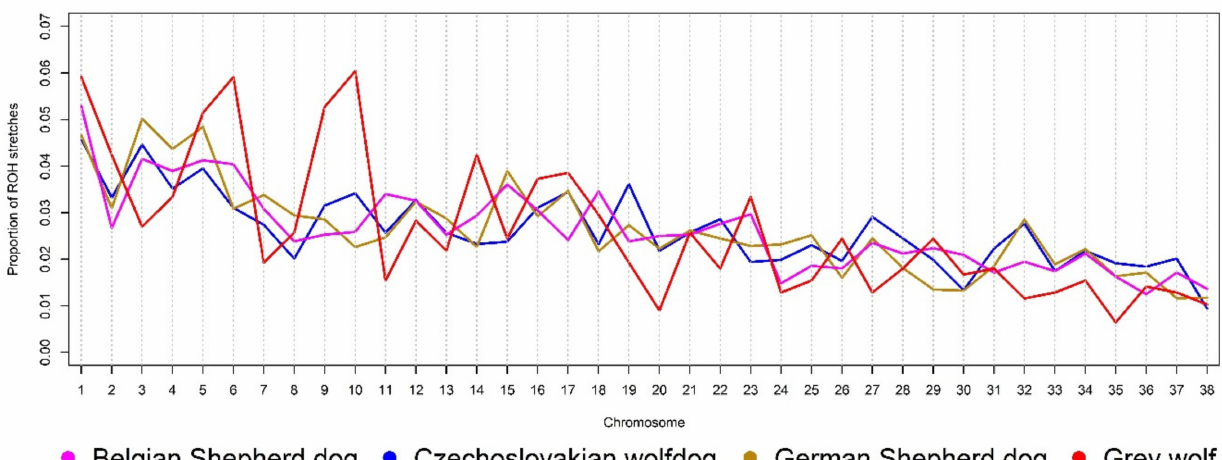
Figure 1. The relative proportion of ROH segments across the autosomal genome of the analysed